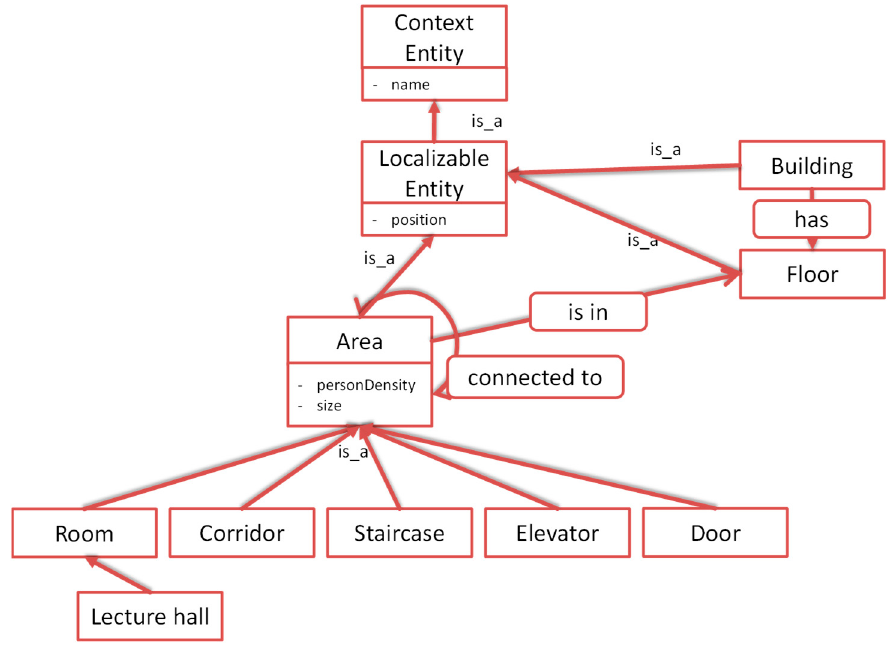
Figure 3. Conceptual context model of the COVID-safe navigation app.